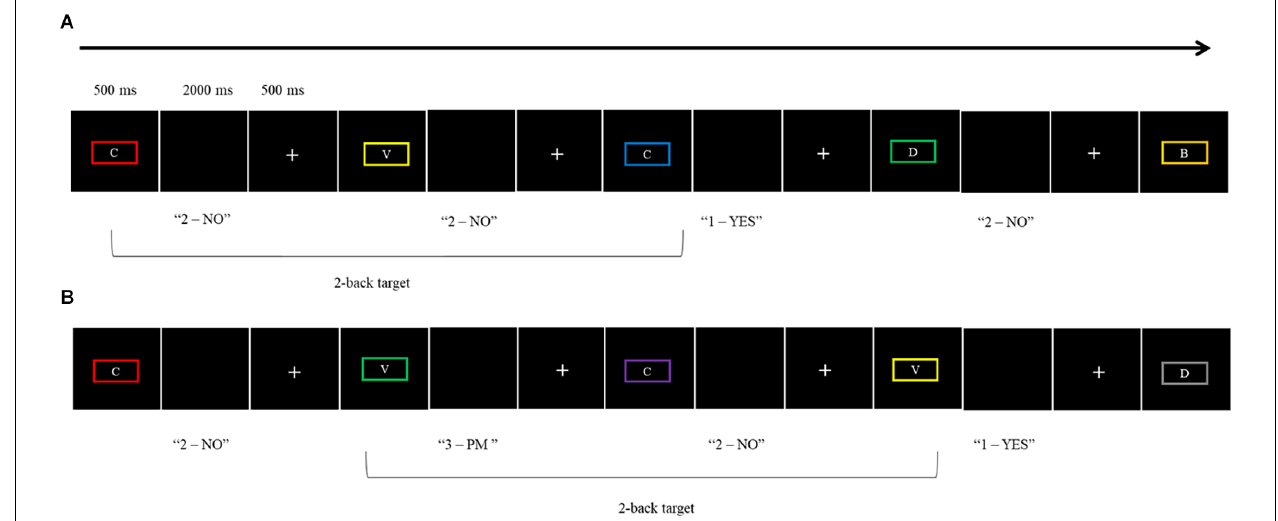
FIGURE 1 | Schematic illustration of the two experimental conditions: (A) WM Condition, (B) WM plus PM